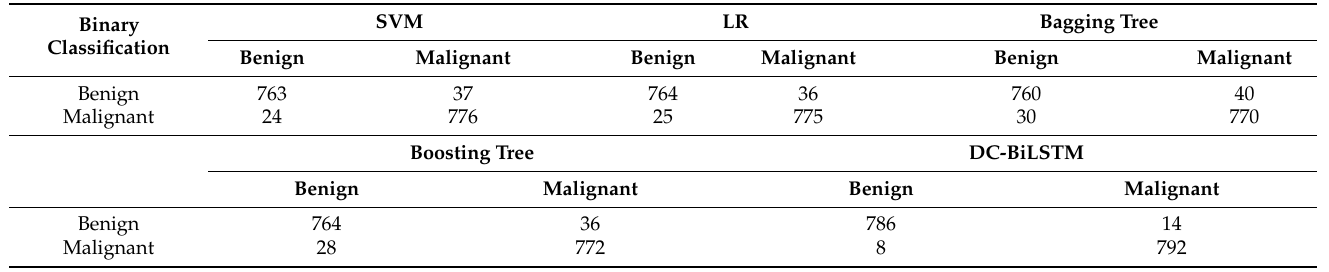
Table 7. Confusion matrices of classification algorithms—Malignant vs. Benign (internal test